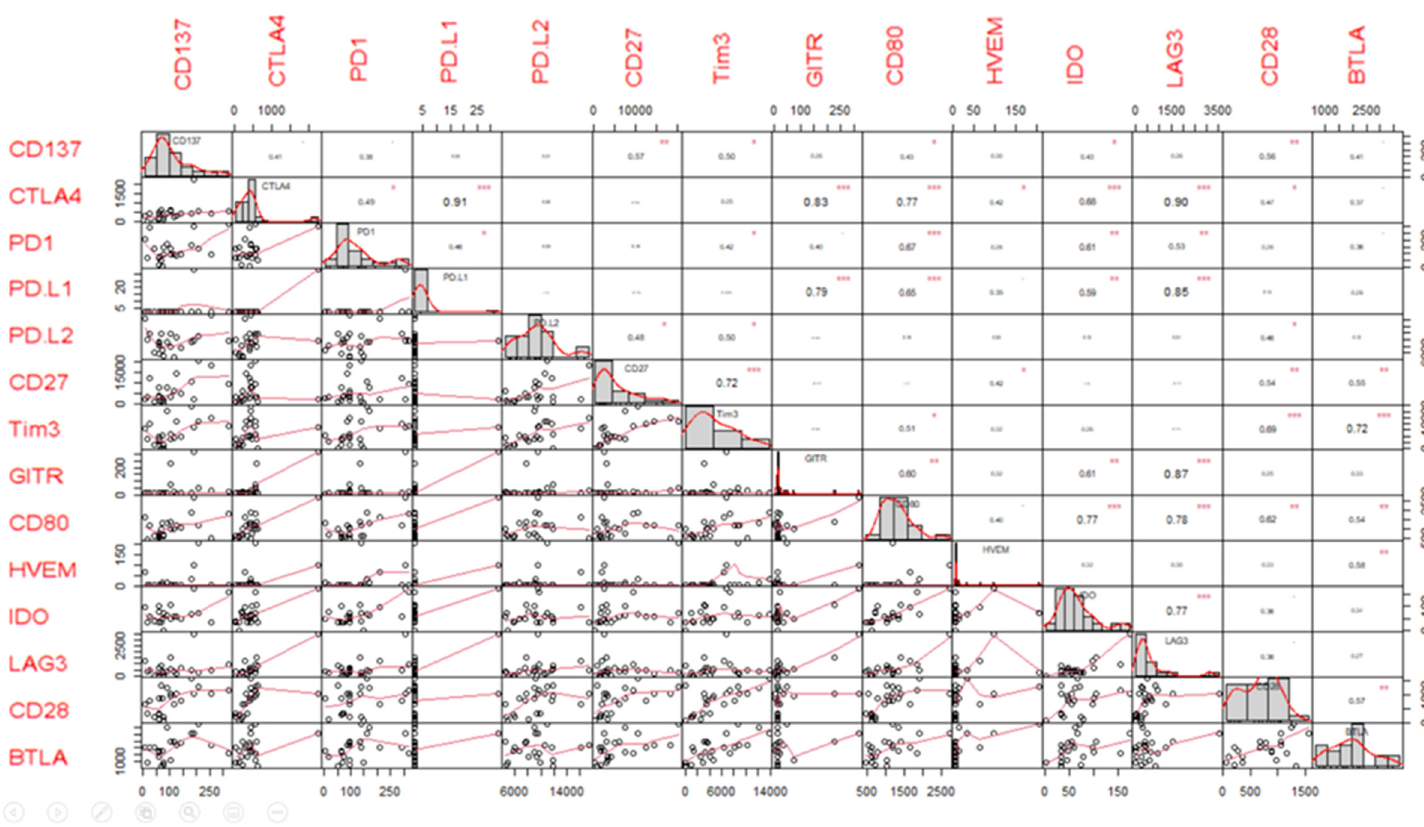
Figure 1. Baseline sICs values and Pearson’s correlation matrix for soluble pairs. This allows for the identification of the distribution of each variable (on the diagonal), the bivariate scatter plots between variables with a fitted line (on the bottom of the diagonal), and the correlations between investigated variables and the significance level of the Pearson’s correlation test. The Pearson’s correlation matrix is for all the pairs of soluble factors reported in Table 2. The distribution of each variable, expressed in pg/mL, is shown on the diagonal. On the bottom of the diagonal, the bivariate scatter plots with a fitted line are displayed. On the top of the diagonal, the value of the correlation plus the significance level of the correlation test as stars are reported. The significance levels are associated with a symbol i.e., the p -values of <0.001, <0.01, and <0.05 are indicated as “***”, “**”, and “*”, respectively. p -values indicating a trend ( p < 0.100) are indicated as”.”.